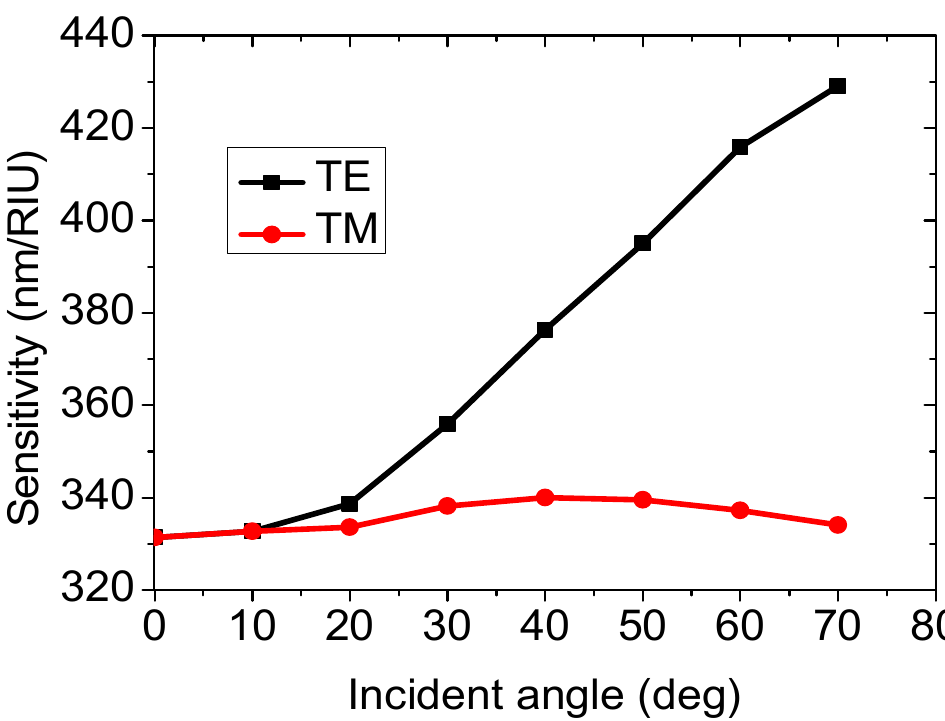
Figure 6. Sensitivity versus incident angle for both TE and TM modes at h f = 500 nm. Table 3. Position of resonant peak and sensitivity ( S ) of creatinine concentration for different incident angles at n 1 = 3.3, n 2 = 1.28, n 3 = 1.46, h 1 = 120 nm, h 2 = 190 nm, h 3 = 260 nm, h f = 500 nm, and N = 4 (TM